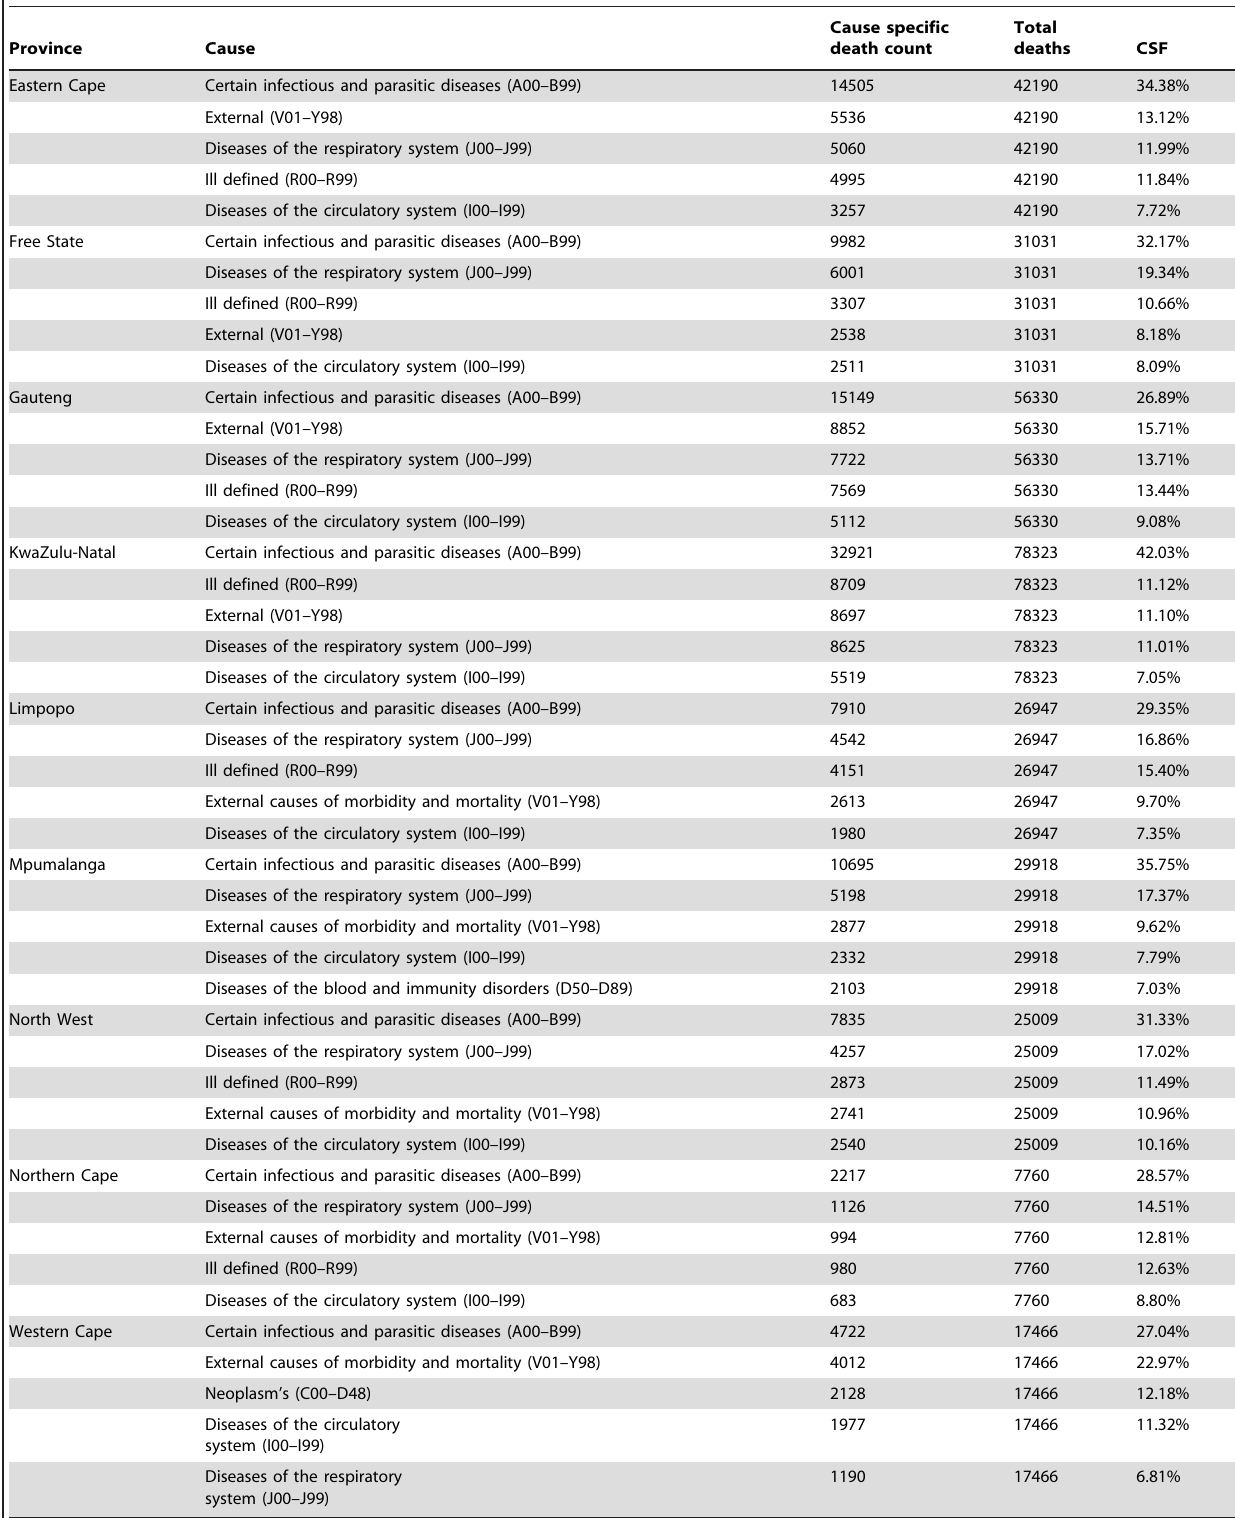
Table 1. Top five broad causes of death by province, South Africa, 2007.